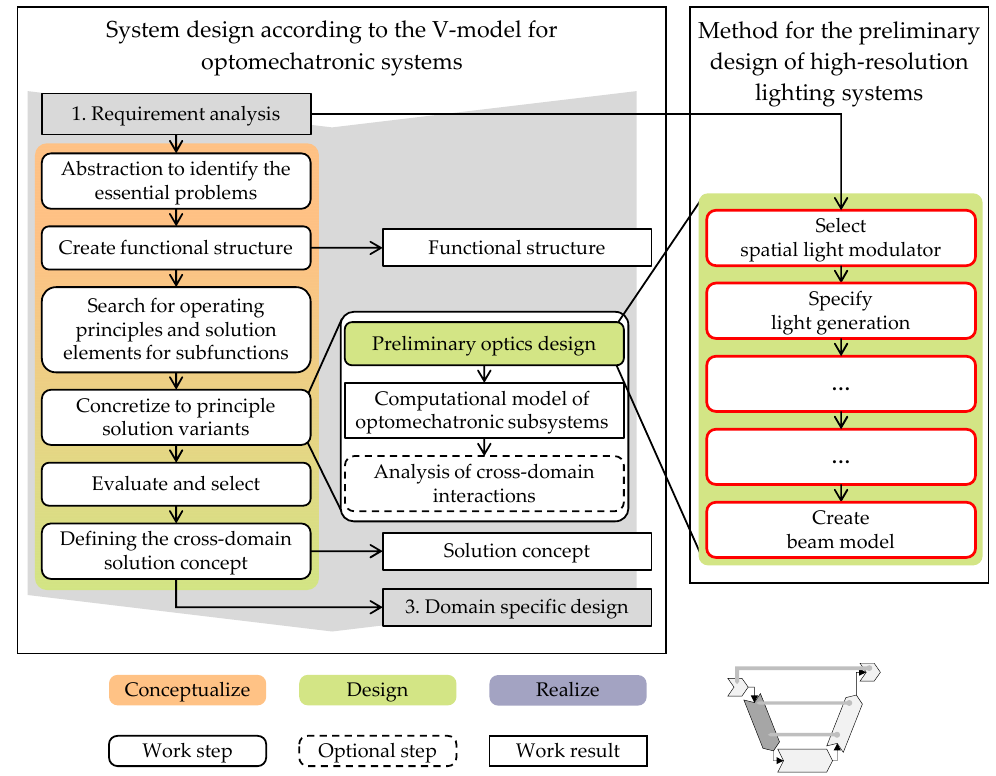
Figure 6. Process phase for the system design of optomechatronic systems according to [9] extended by the method for the preliminary design of high-resolution lighting systems according to [16]; The dark grey box in the pictogram of the V-Model in the lower right serves as orientation which process phase is